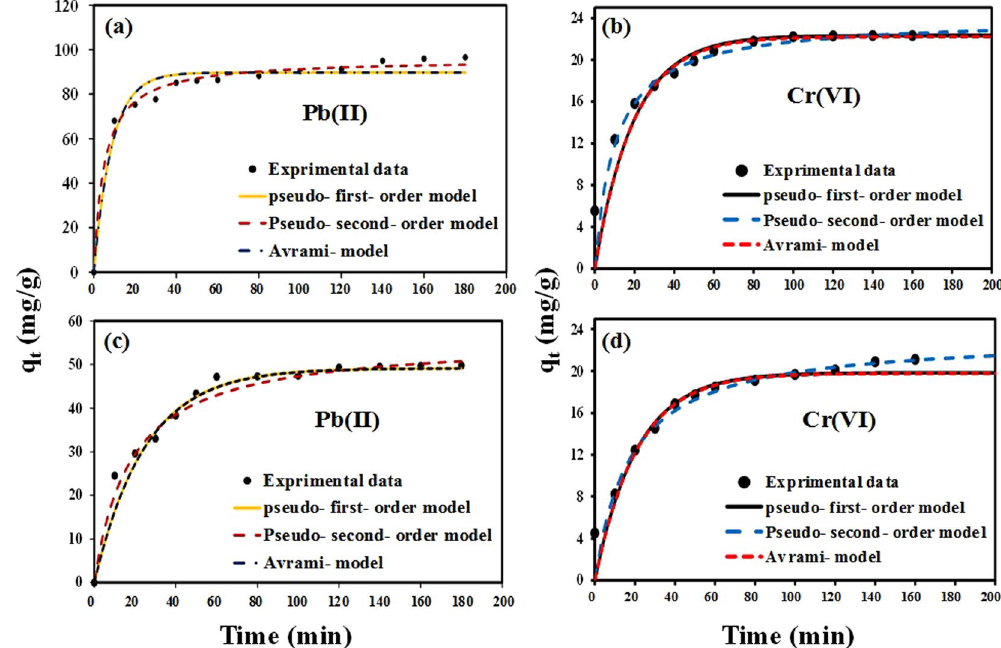
Figure 6. Adsorption kinetics of Pb(II) and Cr(VI) ions adsorption by ( a , b ) PG-C and ( c , d ) CNF-C nanocomposites and fitting of different kinetic models to the experimental